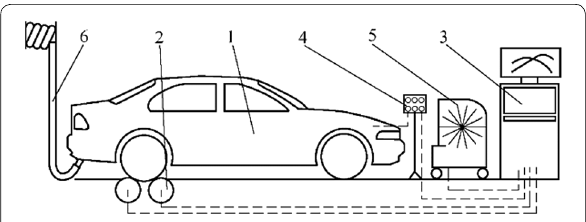
Figure 4 Test stand: 1. tested vehicle; 2. twin‑roller type chassis dynamometer with eddy‑current brake; 3. dynamometer control system; 4. vehicle signals connector box; 5. fan; 6. exhaust gas